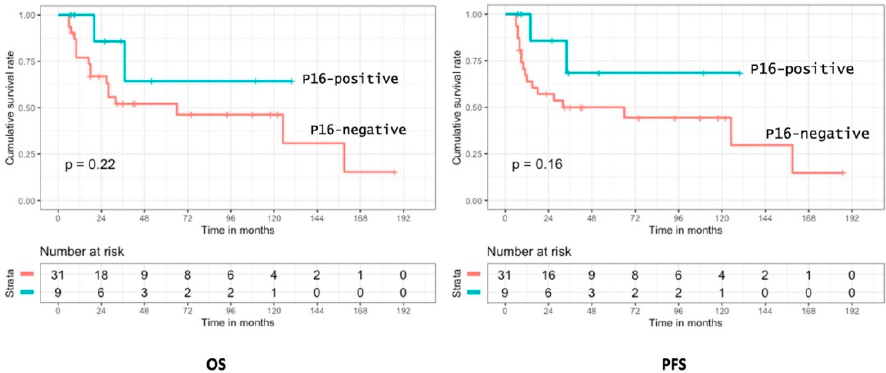
Figure 5. Overall survival and progression-free survival according to p16 expression in SNSCC.